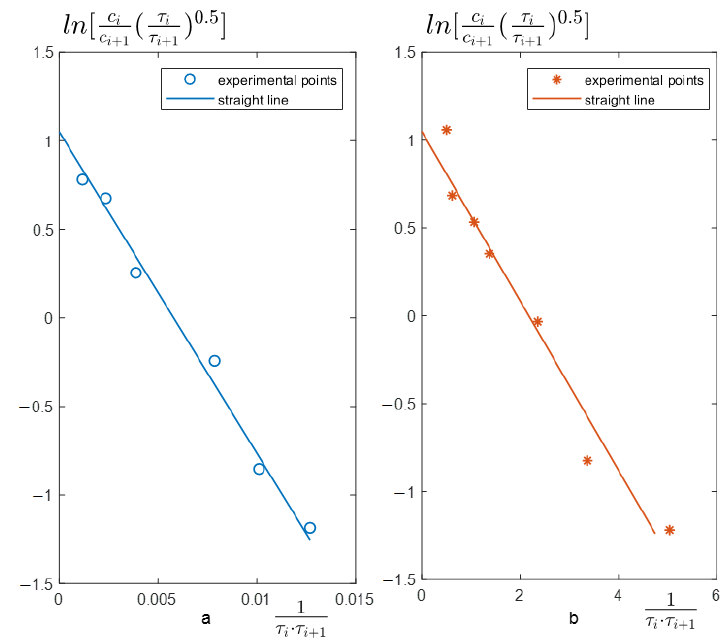
Figure 3. The dependence of lnS c = ϕ ( 1/ τ i · τ i + 1 ) for the dispersion model for two experimental data points ( a , b ) .